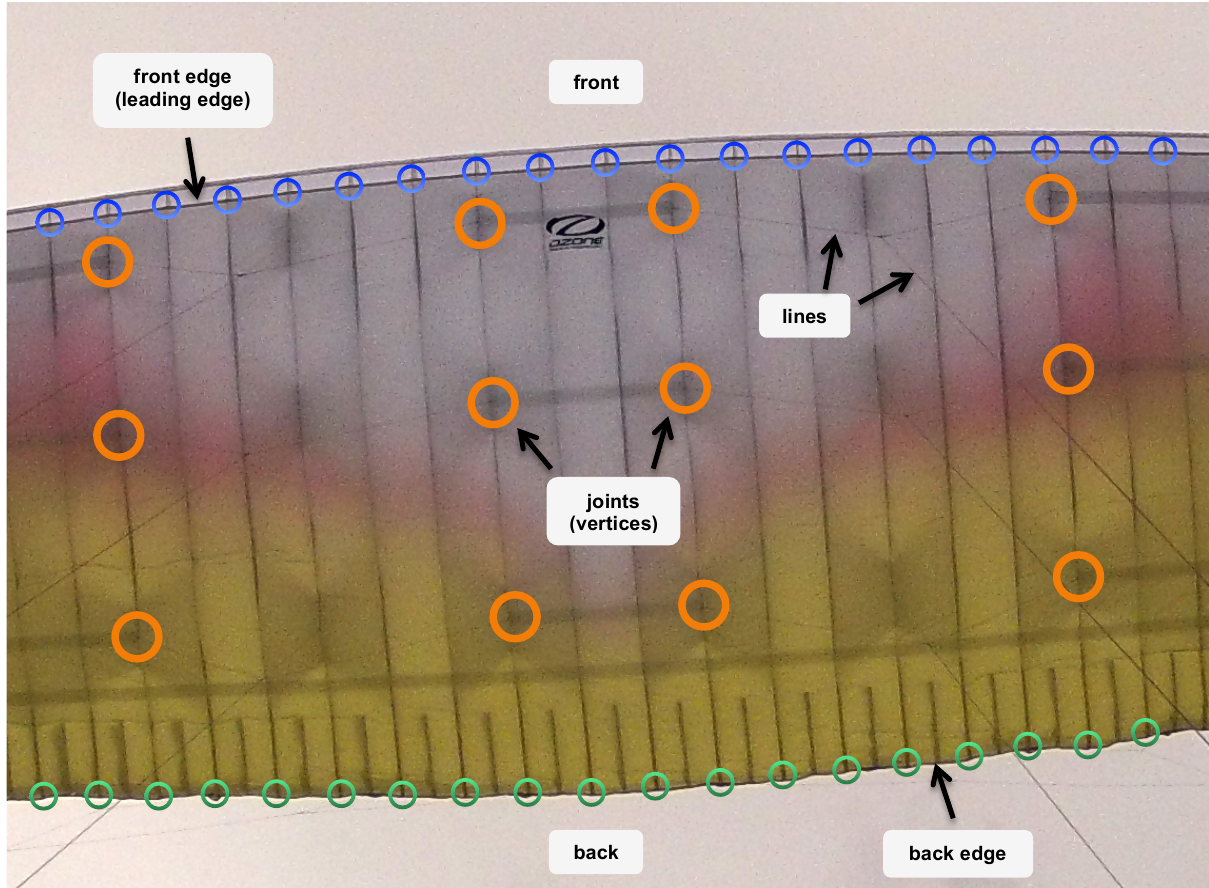
Fig. 2: Some points and curves of interest to be measured